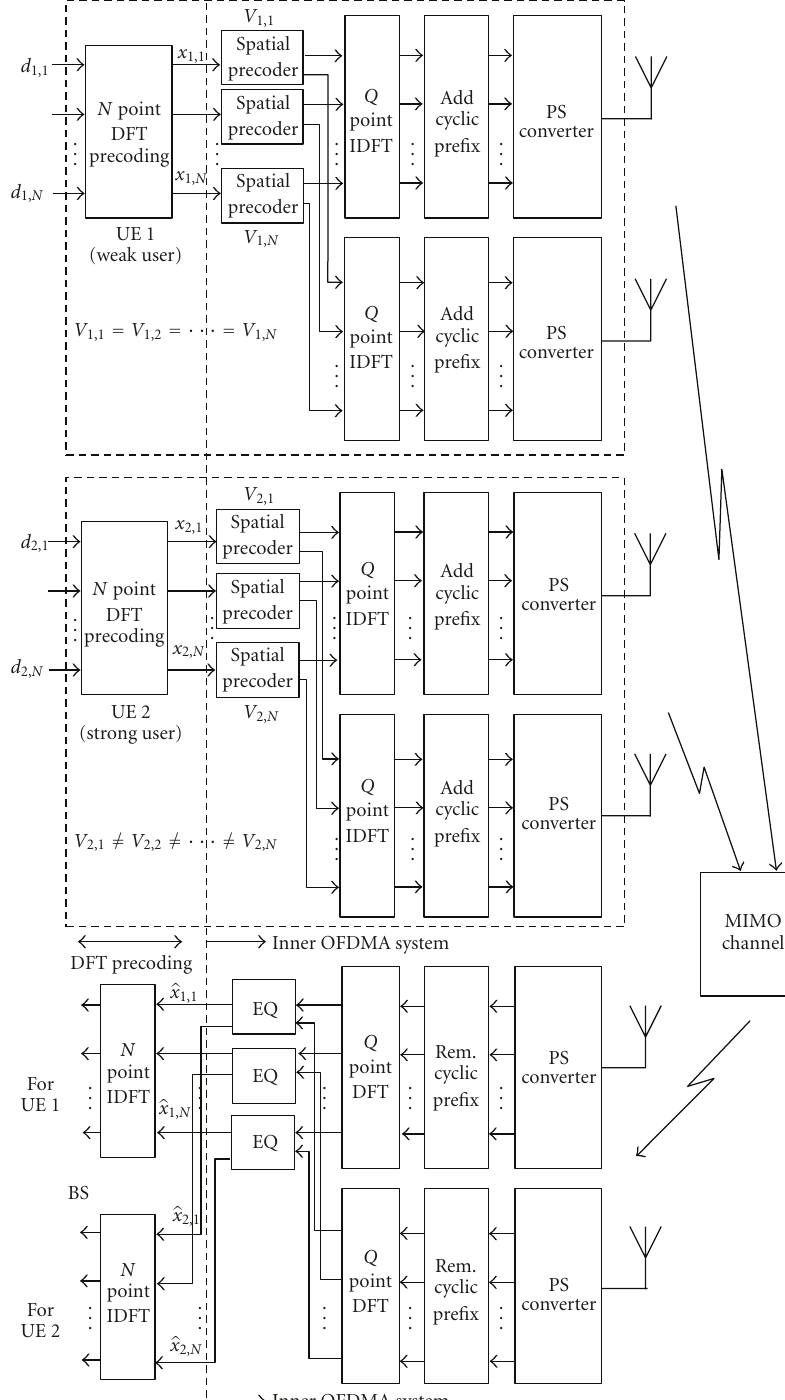
Figure 1: Block diagram of the SC-FDMA MIMO system with two UEs under consideration.